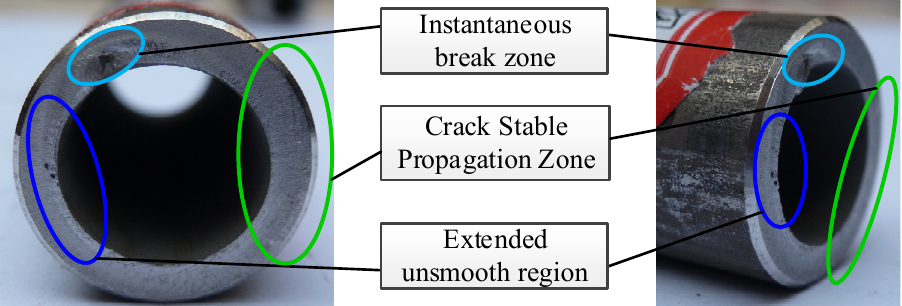
Figure 16. Tubing fatigue fracture precision separation section.